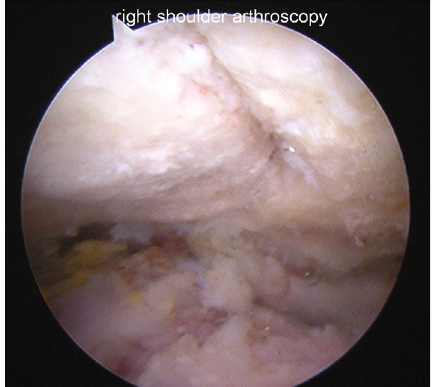
Figure 2: Arthroscopic image of the prepared bony surfaces prior to fi xation.